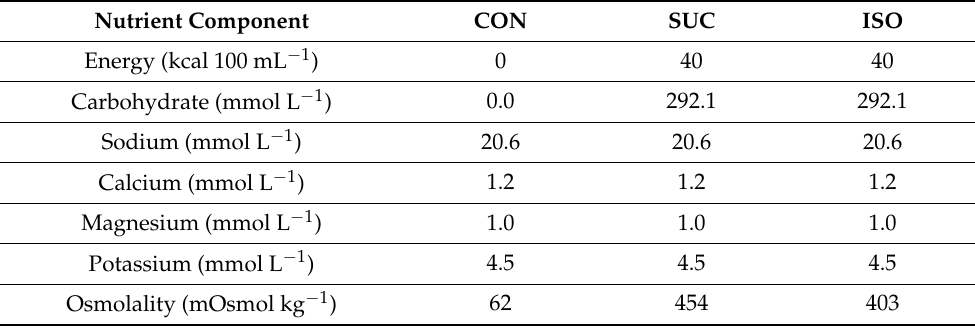
Table 1. Nutrient component in the test